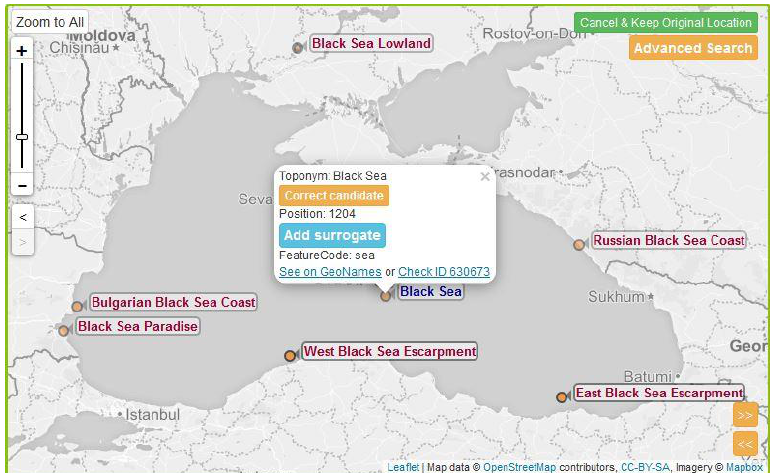
Figure 9. Clicking on each toponym invokes a popup displaying a list of special tags, the spatial hierarchy of the toponym, its feature code (type) and link to entries on GeoNames for more information on each toponym. Users can use the “see alternative locations” button to see alternative toponym candidates for a place name.